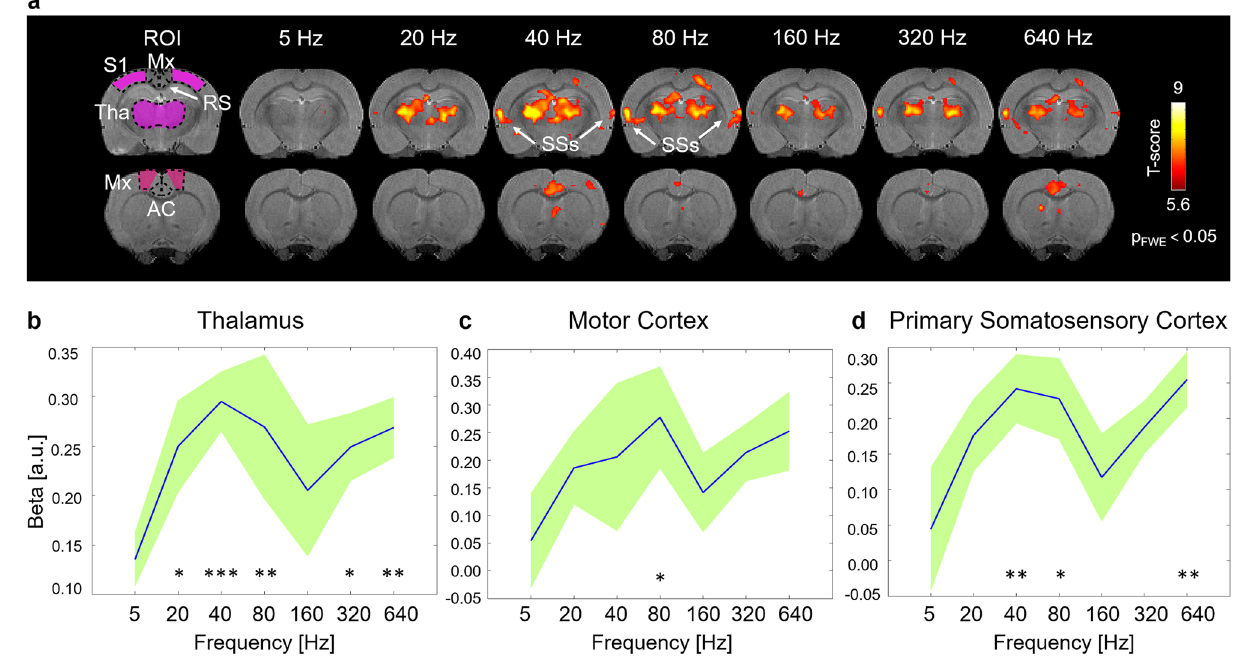
Figure 2. Group level responses to single contact/wire monopolar ESCS at different stimulation frequencies. ( a ) Group level maps of the main effects (t-maps) in two different brain slices. Maps were obtained by the one-way within subject ANOVA model (p < 0.05 family wise corrected (FWE) n = 6). ROI-averaged beta values in the thalamus ( b ), the motor cortex ( c ) and the primary somatosensory cortex ( d ) in response to different stimulation frequencies. Blue line indicates mean while green shading indicates the standard deviation. Holm’s corrected *p < 0.05, **p < 0.01, ***p < 0.001 (linear mixed model comparisons vs 5 Hz). S1 primary somatosensory cortex, Mx motor cortex (including primary and secondary motor cortices), RS retrosplenial, Tha thalamus, AC anterior cingulate cortex, SSs supplementary somatosensory cortex. Brain images are displayed in neurological convention (left side of the image corresponds to the left side of the